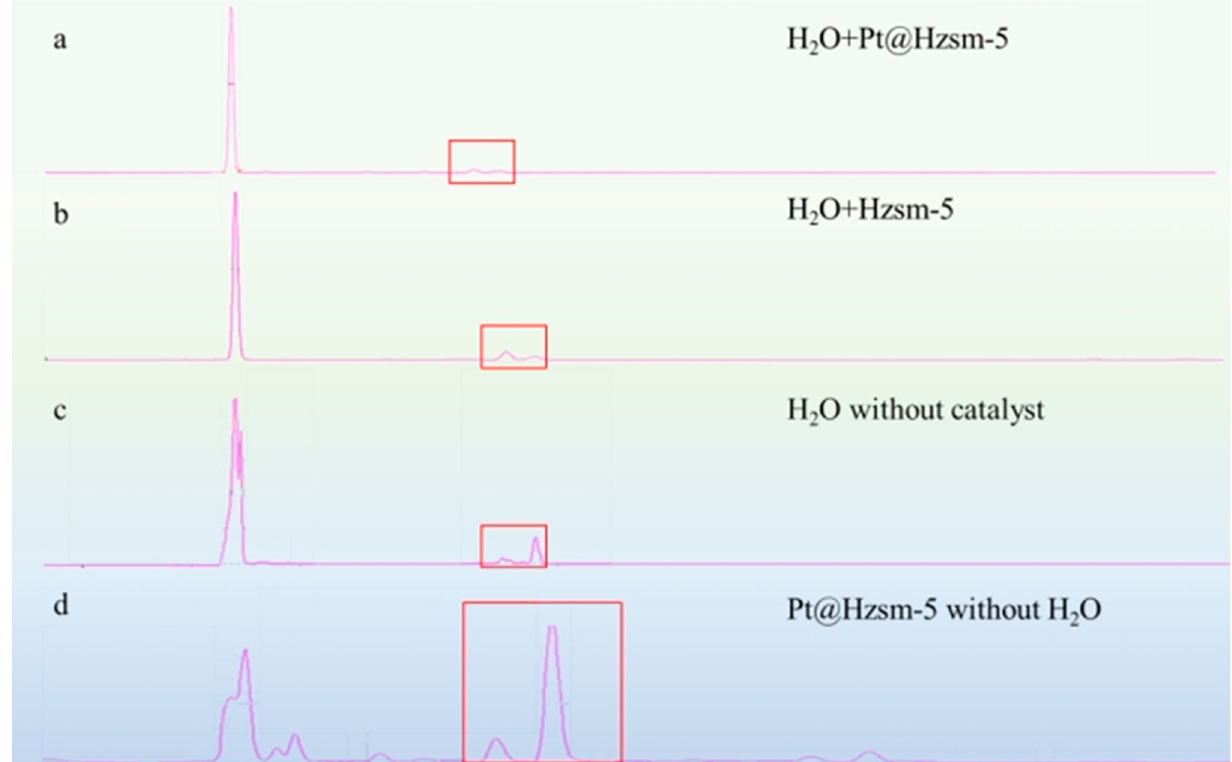
Figure 5. HPLC analysis of the solid products (The main impurity mTPA is in the red suares): ( a ) solid products obtained from the Pt@Hzsm-5 catalytic steam-assisted pyrolysis; ( b ) solid products obtained from the Hzsm-5 catalytic steam-assisted pyrolysis; ( c ) solid products obtained from the steam-assisted pyrolysis without catalyst; ( d ) solid products obtained from the Pt@Hzsm-5 catalytic pyrolysis without water.